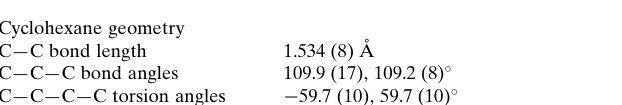
Cyclohexane geometry C—C bond length